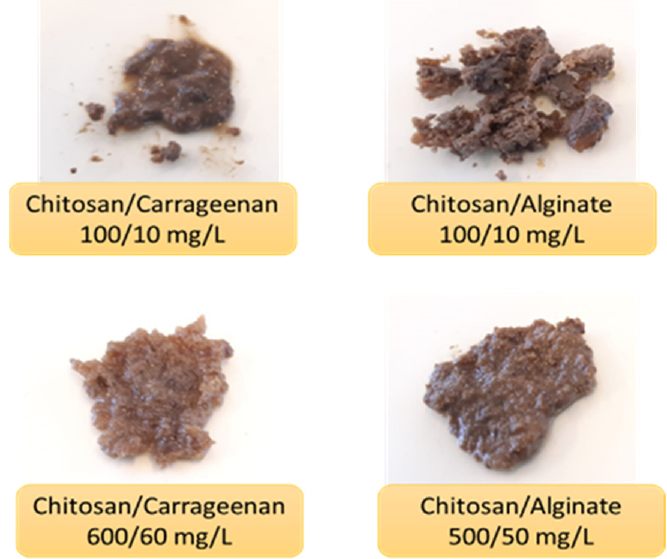
Figure 7. Visual aspect of the selected solid fractions after sterilisation.